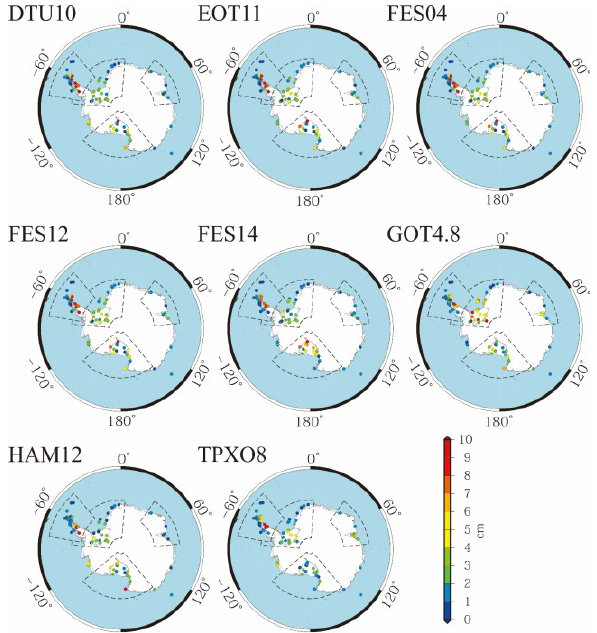
Figure 5. Magnitudes of vector differences between observed and bilinearly interpolated K 1 signals. All eight models and their RSS show the similar spatial patterns, where the largest vectors are in the regions of Antarctic Peninsula and under the big ice shelves.